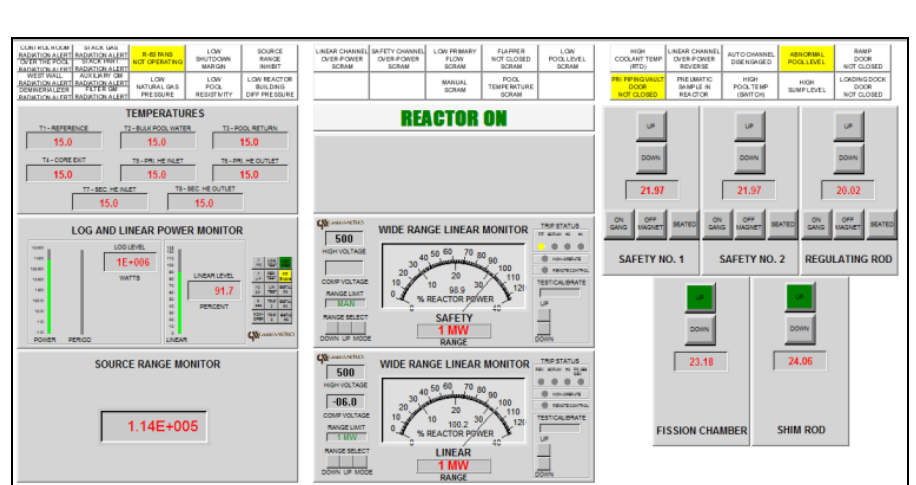
Fig. 2. Original first generation NetSuite PULSTAR console GUI.